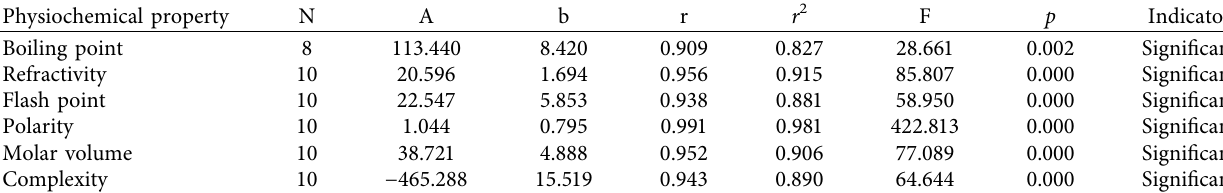
Table 6: Statistical parameters used in the QSPR model of GA(G).